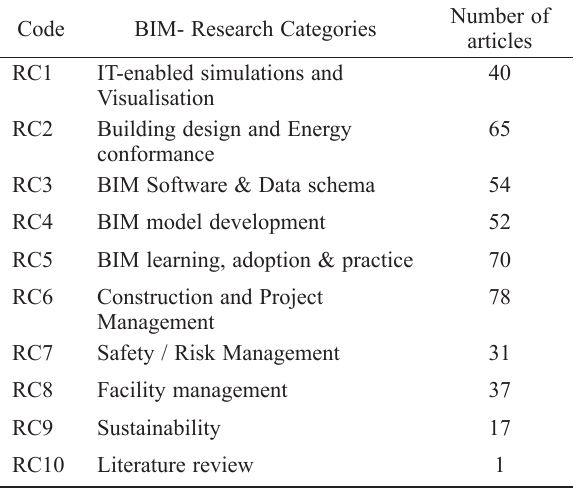
Table 5. BIM research